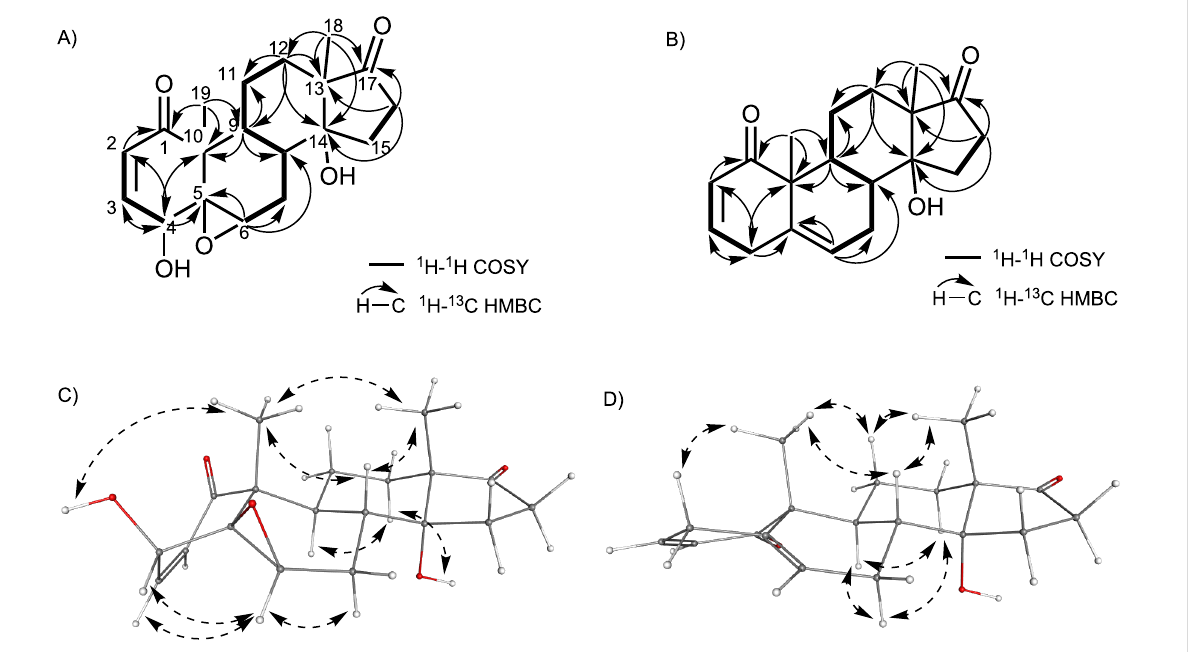
Figure 2: Key NMR correlations. (A) COSY and HMBC correlations for irinan A ( 2 ). (B) COSY and HMBC correlations for irinan B ( 3 ). (C) Key NOESY correlations for irinan A ( 2 ). (D) Key NOESY correlations for irinan B ( 3 ).